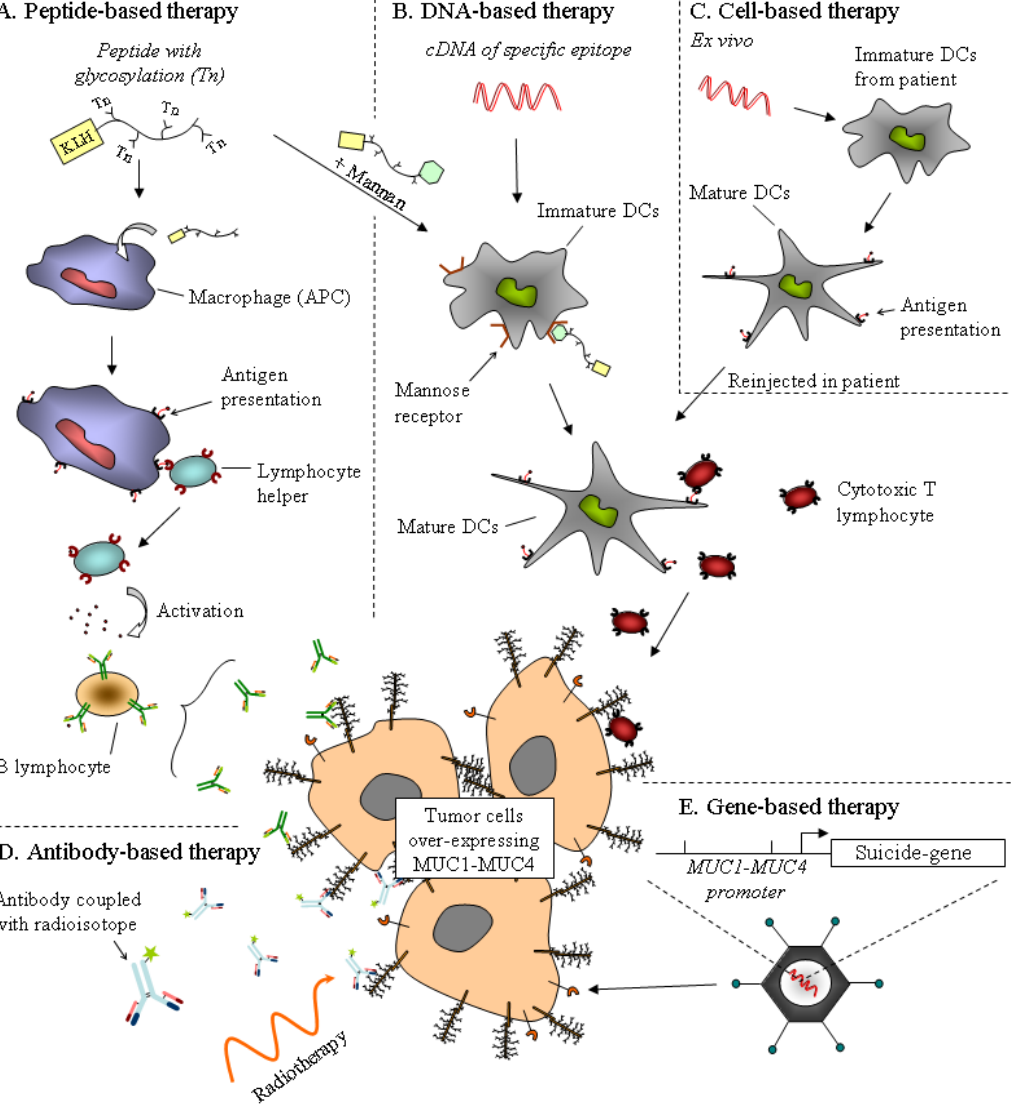
Figure 2. Strategies for mucin-based therapies already used in phase trial. The aim of antigen-based therapy, by the use of a peptide or a cDNA derived from mucin epitopes, is to activate the immune system against tumor cells overexpressing the mucin. ( A ) The glycosylated mucin peptide, with KLH adjuvant, activates the humoral response by the activation of antigen-presenting cells (APC). The efficiency of this peptide may be increased with a mannan epitope recognized by a mannose receptor on dendritic cells (DCs), which in turn activates the cytotoxic response. ( B ) DNA vaccine encoding a specific mucin epitope is incorporated by DCs and activates the cytotoxic T lymphocyte. ( C ) Cell-based therapy is an alternative of DNA vaccine. Immature DCs extracted from the patient are incubated with DNA encoding the mucin epitope. Activated DCs exhibiting mucin antigen are injected into the patient. ( D ) Antibody-based therapy. Use of antibodies is promising for the detection and treatment of cancer. Antibodies against mucin epitopes are coupled with a radioisotope for radiotherapy ((131)I-PAM4) or a cytotoxic drug to target tumors. ( E ) Gene-based therapy. Promoter of mucin may be used to deliver a cytotoxic agent on tumor